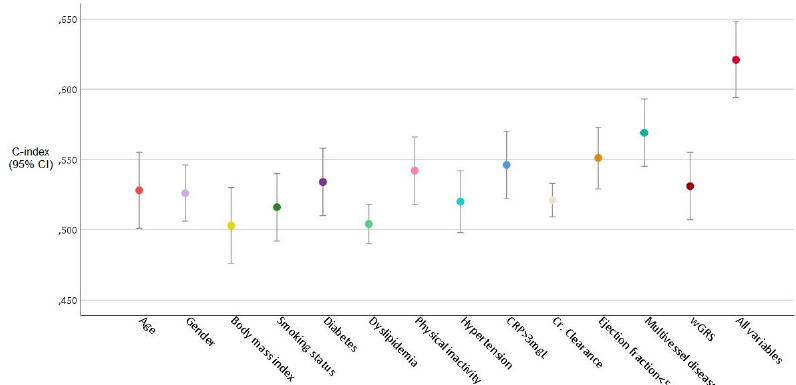
Figure 3 ‒ Individual predictive capacity of the investigated variables to MACE risk by C-index